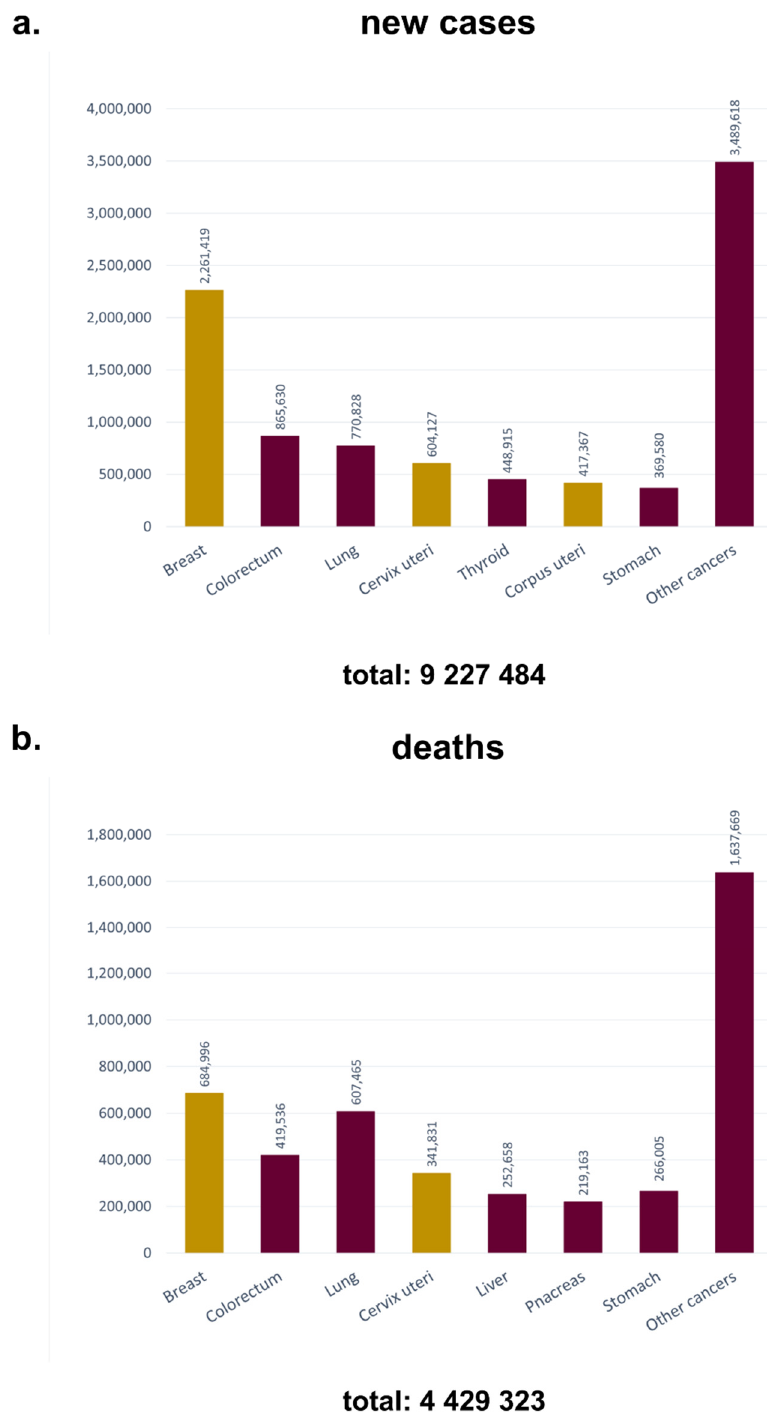
Figure 1. Graphs present reported Globocan 2020 data. ( a ) the number of new cases and ( b ) deaths in 2020 for women aged 0–85+ [8].